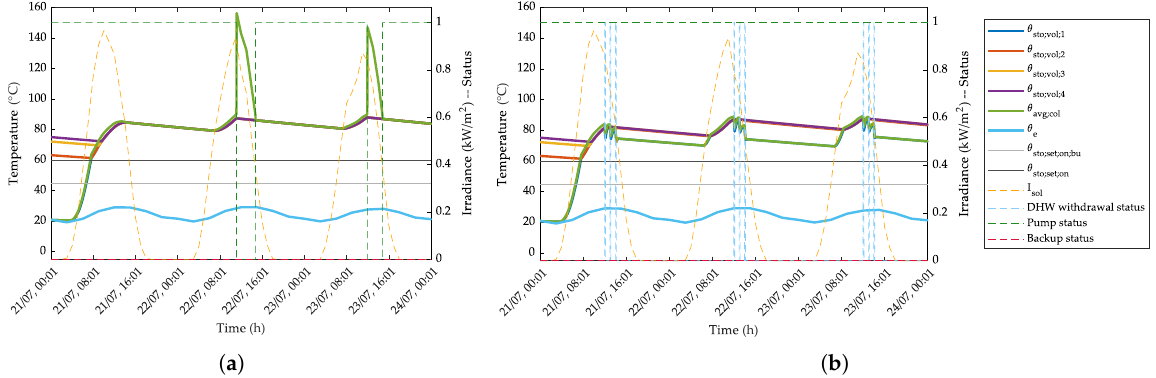
Figure 13. ( a ) Overheating at the beginning of a summer vacation period (no load). ( b ) Simulation with custom discharge profile. Time step: 1